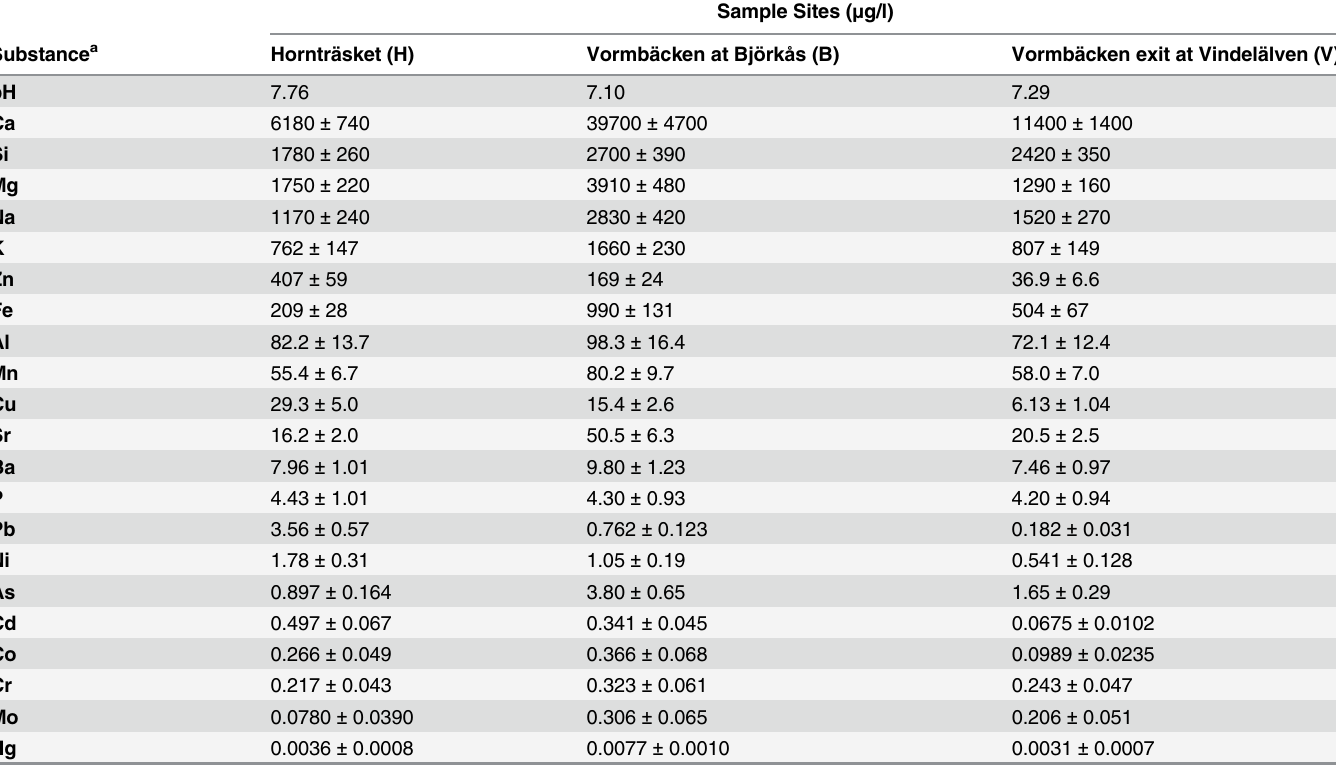
Table 2. Chemical analysis of water samples from Lake Hornträsket and the Vormbäcken